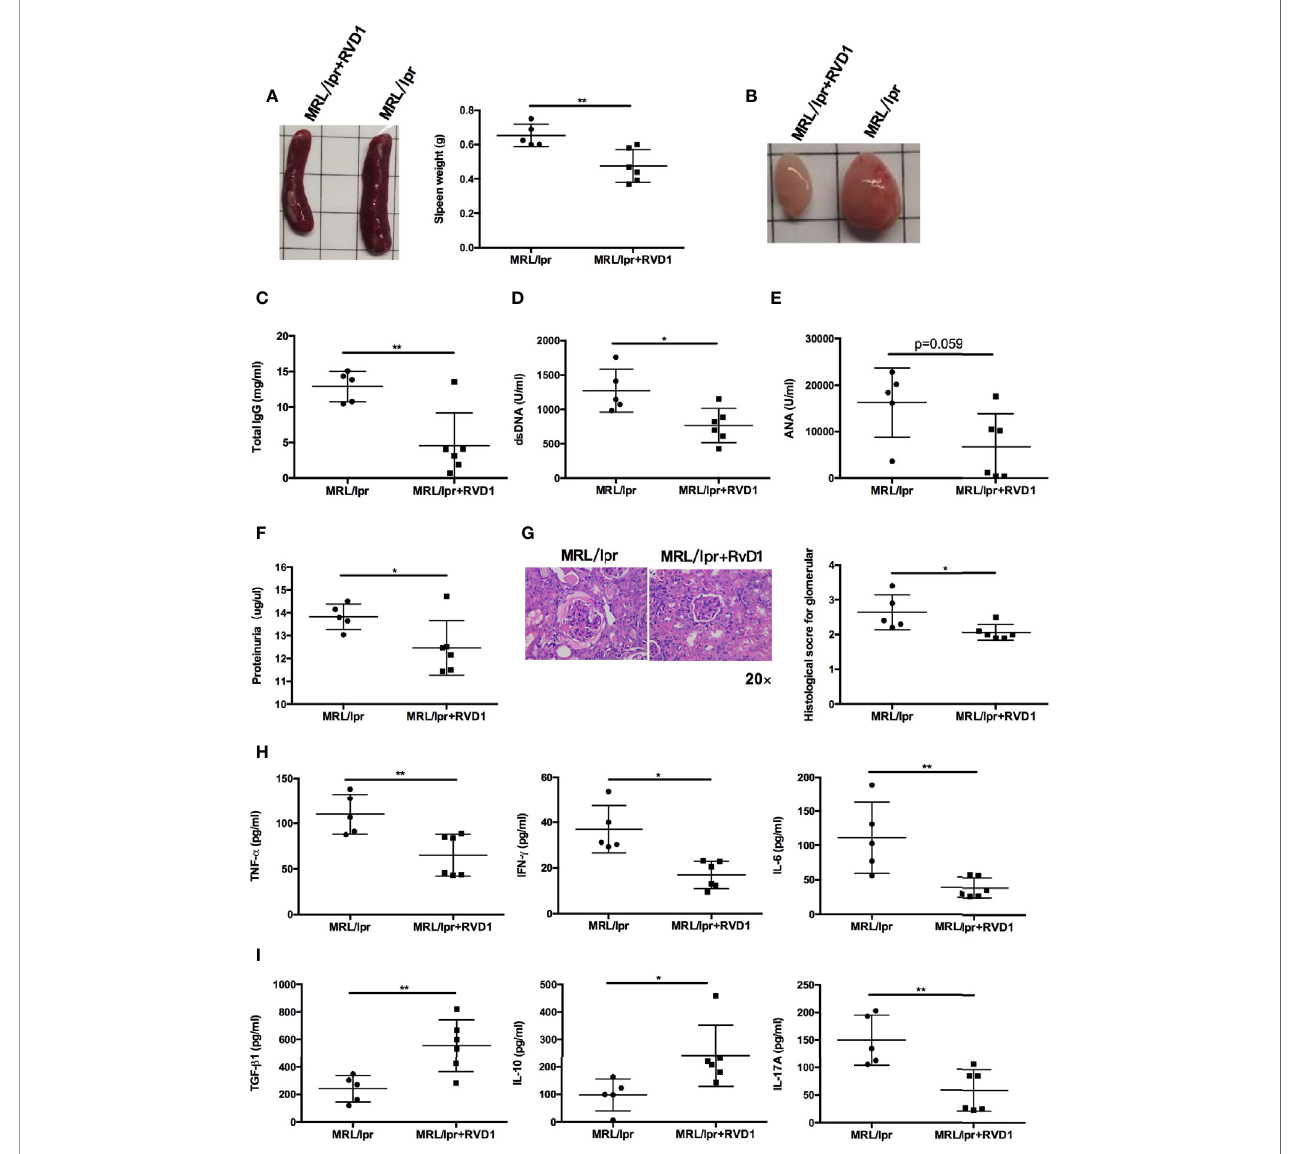
FIGURE 3 | RvD1 treatment ameliorates disease phenotype and in fl ammatory response in MRL/ lpr mice. RvD1 treatment reduced spleen index (A) , lymph node size (B) , plasma levels of total IgG (C) , anti-dsDNA antibodies (D) , ANA (E) , proteinuria (F) , glomerular enlargement and hypercellularity (G) , pro-in fl ammatory cytokines (TNF- a , IFN- g and IL-6) (H) and a Th17 cell-related cytokine (IL-17) (I) , while increase Treg cell-related cytokines (IL-10 and TGF- b ) (I) in MRL/ lpr mice. All data are mean ± SEM. n=5 in MRL/ lpr group; n=6 in MRL/ lp r+RvD1 treated group. * p < 0.05; ** p <